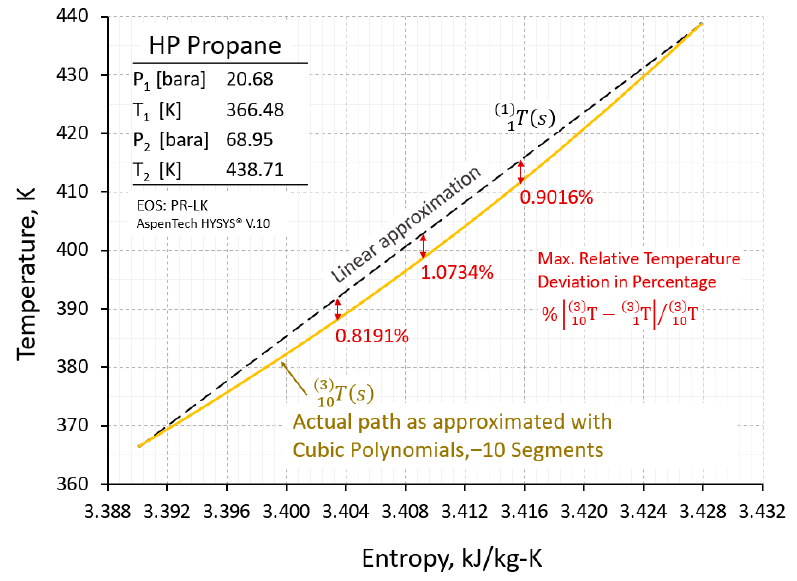
Figure 3. Temperature deviation of the linear approximant from the actual polytropic path as approx- imated with 10-segment piecewise cubic polynomials is shown. The highest temperature deviation is 4.276 K (1.0734% relative deviation), in the middle of the interval range (s = 3.409 kJ/kg-K). The error in estimating the degraded energy is 𝐸𝑟 (cid:2869)((cid:2869)) 𝑇𝐷𝑆 = 0.1054 kJ/kg (0.698% relative deviation), which is represented by the area bounded between the two curves of 𝑇 (cid:2869)((cid:2869)) (𝑠) and 𝑇 (cid:2869)(cid:2868)((cid:2871)) (𝑠) .